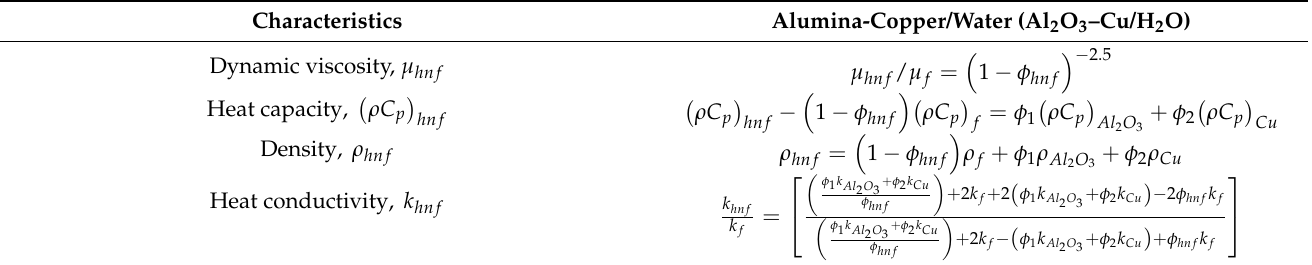
Table 1. The characteristic properties. (Takabi and Salehi [13]; Ghalambaz et al. [61]). Characteristics